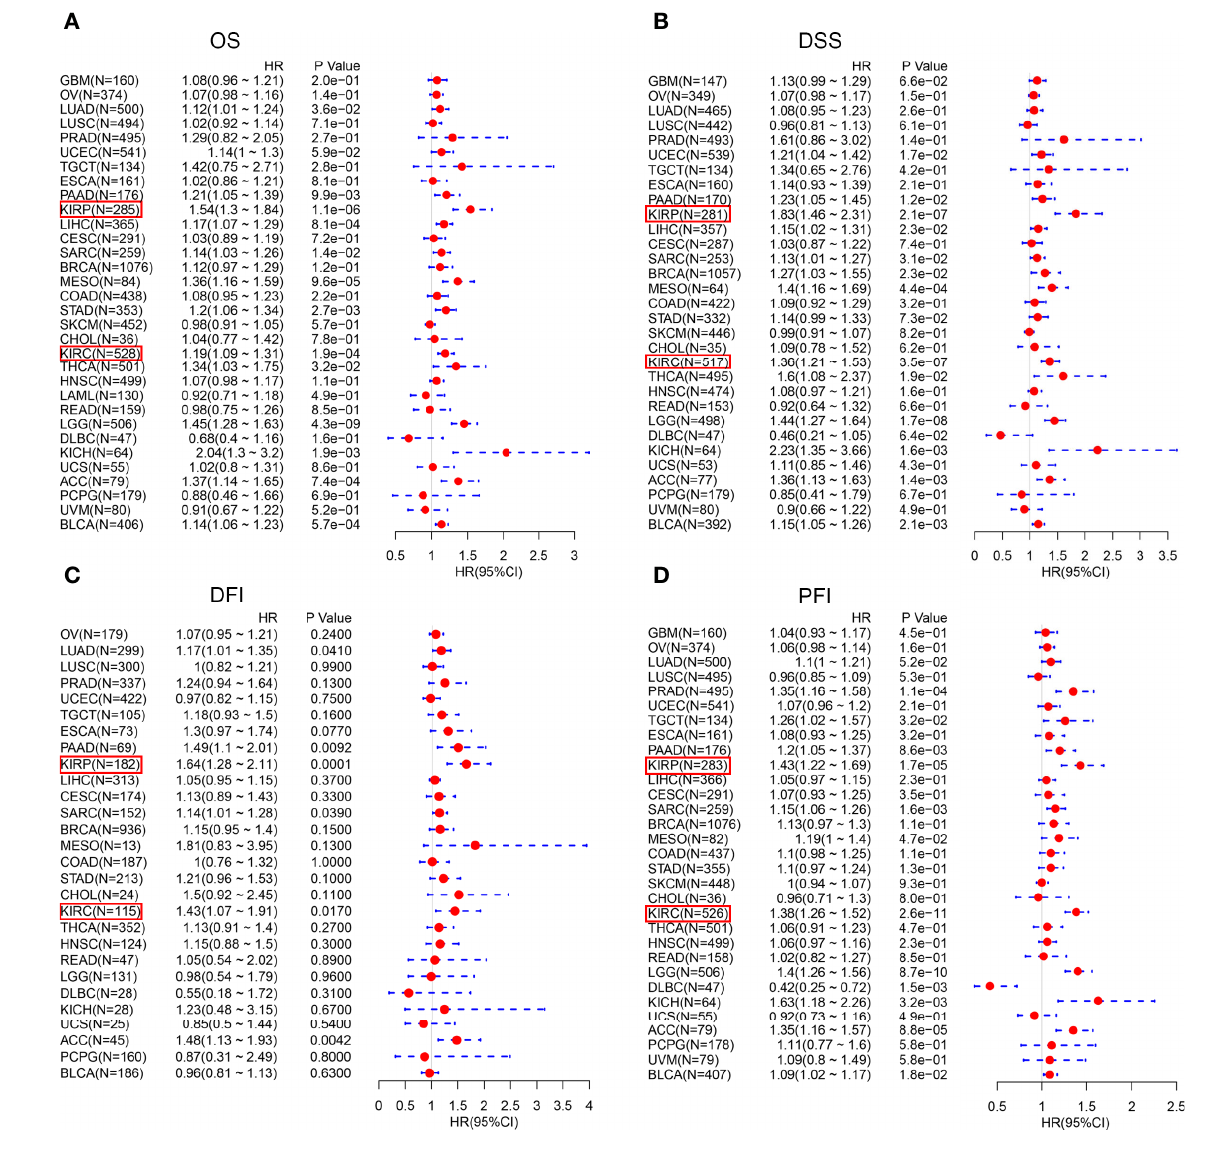
FIGURE 3 | Forest plot of the prognostic values in various cancer subgroups of CTHRC1 . (A – D) Prognostic HR of CTHRC1 in different cancers for OS (A) , DSS (B) , DFI (C) , PFI (D)